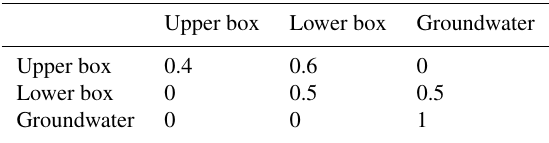
Table 2. Square matrix used to partition runoff generation between buckets in the PERSiST application presented here. For example, we conceptualized that 40% of the precipitation inputs are retained in the upper box, 60% are transferred to the lower box and 0% are transferred to the groundwater (row